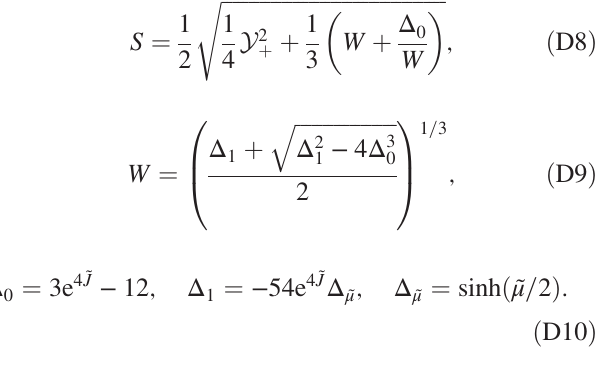
FIG. 13. Stationary points of the Bethe-Guggenheim free energy density for zero force, given by Eqs. (D7a) and (D7b), as a function ˜ J of the coupling strength . From left to right, we consider increasing values of the intrinsic binding affinity ˜ μ . The variable φ 0 1 the location of the global minima, which is given by Eq. (D14) for zero intrinsic binding affinity (a), and given by Eq. (D16) for nonzero ˜ J intrinsic binding affinity (b,c). The coupling value Δ ¼ 0 , given by Eq. (D12), indicates the coupling strength where all four solutions become real, and it denotes the first appearance of a local maximum given by φ 4